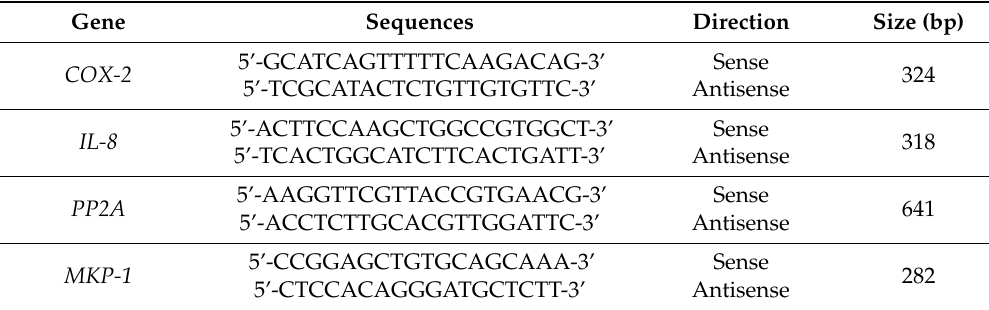
Table 1. Oligonucleotide primers for